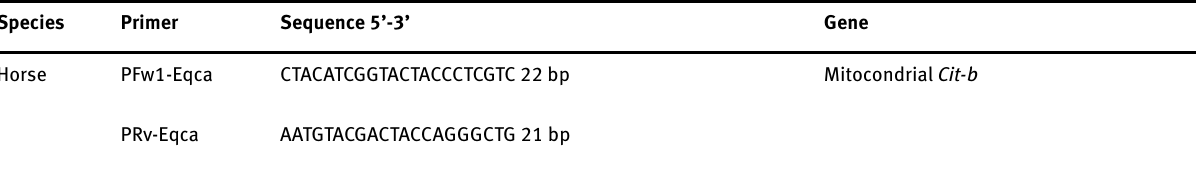
Figure 3 : Extractions with different incubation temperatures with proteinase K, beef: Molecular market 1kb Plus (MM); 5min (R1), 10min (R2), 15min (R3) Table 2: Sequence of specific primers from horse Species